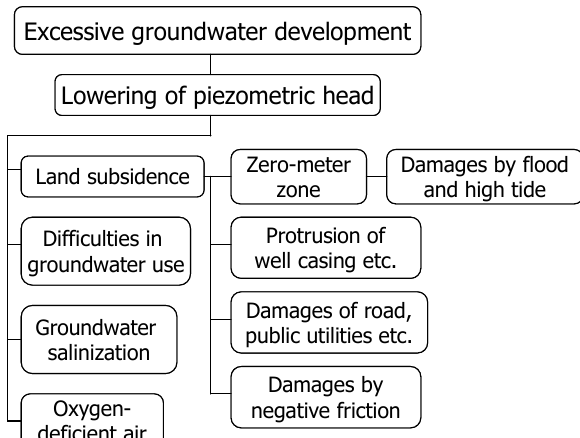
Fig. 1 Japanese experience of environmental consequences due to the excessive groundwater development (Kayane 1989).